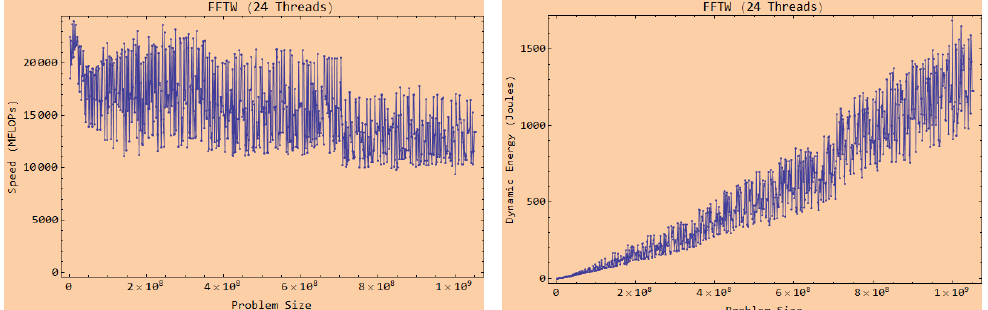
Figure 6. The speed and dynamic energy consumption profiles for the FFTW application employing 24 threads on the Intel Haswell multicore CPU are shown in Figure 1. The application computes a 2D fast Fourier transform (FFT) of a dense signal matrix of size n × n . The problem size on the x-axis is n 2 . The workload size is 5 × n 2 × log n . Therefore, the speed and dynamic energy profiles versus 2 workload size will still be highly non-linear